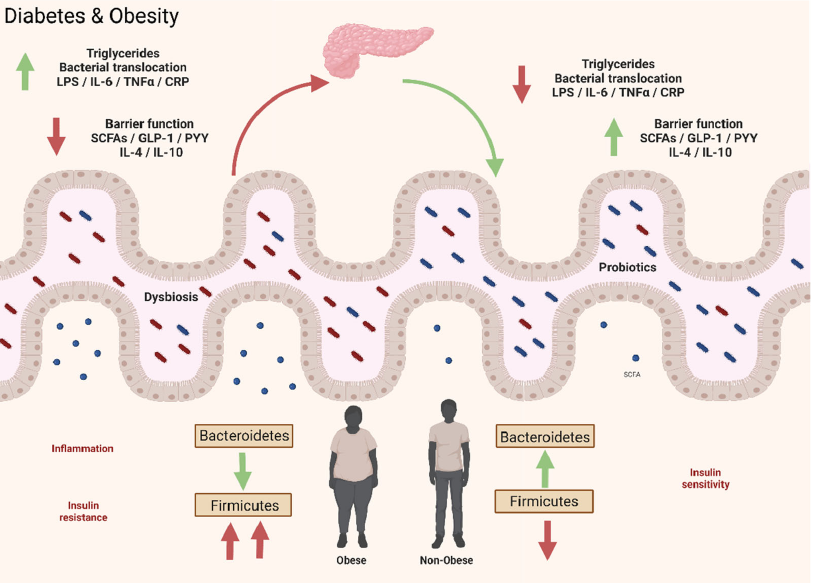
Figure 5. Microbiota–gut–metabolism axis. In obesity and T2DM, the inflammatory state is not produced by infections or autoimmune factors but by metabolic dysfunction in a condition known as